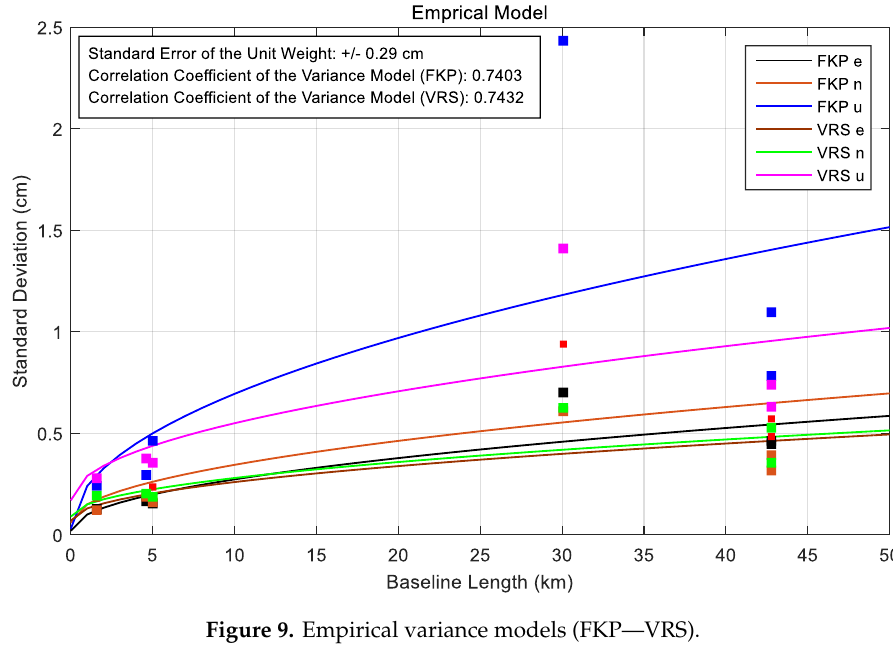
Figure 9. Empirical variance models (FKP—VRS).